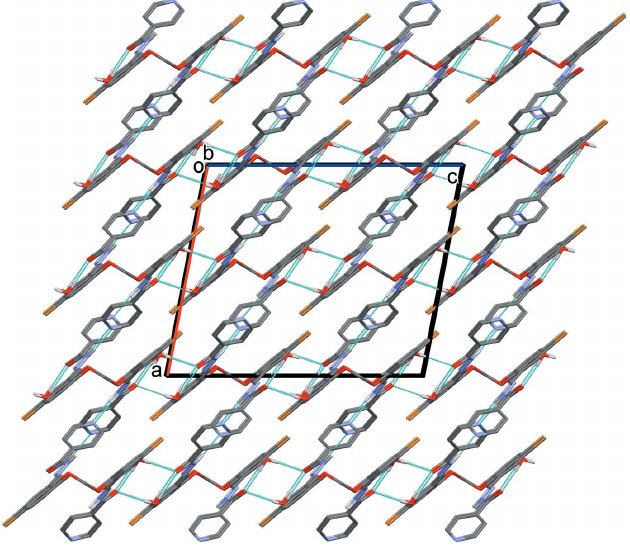
Figure 3 The crystal packing of compound (I), viewed along the b axis. The hydrogen bonds are shown as dashed lines (see Table 3 for details). For clarity, the C-bound H atoms have been omitted.